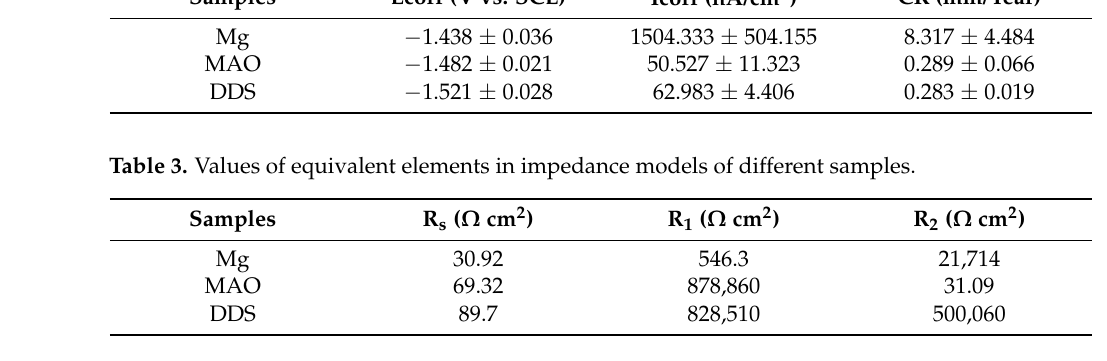
Figure 8. Potentiodynamic polarization curves ( a ), Nyquist plots ( b ), and impedance models ( c ) of Mg alloy, Mg-based MAO alloy, and Mg-based MAO-MT-PLGA DDS. Table 2. The results of Tafel fitting of potentiodynamic polarization curves. Samples